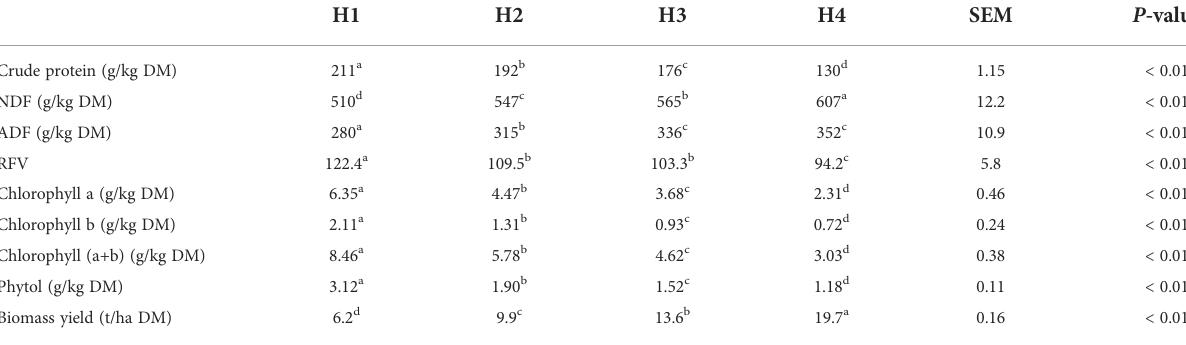
TABLE 1 The chemical composition, chlorophyll, phytol, and biomass yield of Pennisetum sinese at different heights. H1 H2